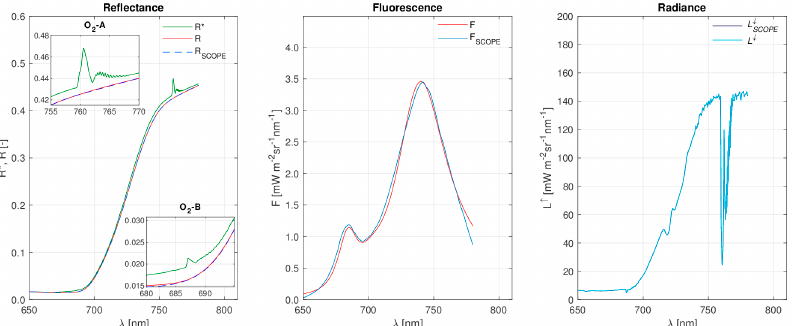
Figure 7. Retrieval of full F spectrum in the 650–780 nm spectral window from RT simulations: ( left ) apparent reflectance ( dark green ), reference reflectance from SCOPE ( dashed blue ) and retrieved reflectance ( light green ); ( middle ) reference fluorescence from SCOPE ( blue ) and retrieved fluorescence ( red ); ( right ) reference and modeled upwelling radiance (( dark and light blue ) respectively).